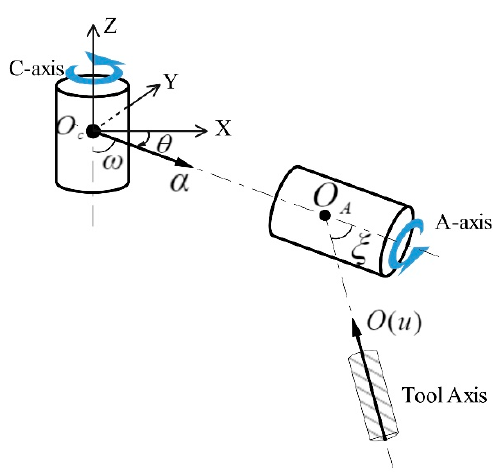
Figure 3. Generic dual-head model of the vertical five-axis machine tool. Since the angle between the tool orientation vector O ( u ) and the unit rotation direction vector of the A -axis is a constant angle ( π − ξ ) , the inner product of the vector O ( u ) and vector α is constant. where dot( , ) is the inner-product function of vectors. The equation of angle θ can be obtained as follows by substituting Equation (8) into Equation (9).